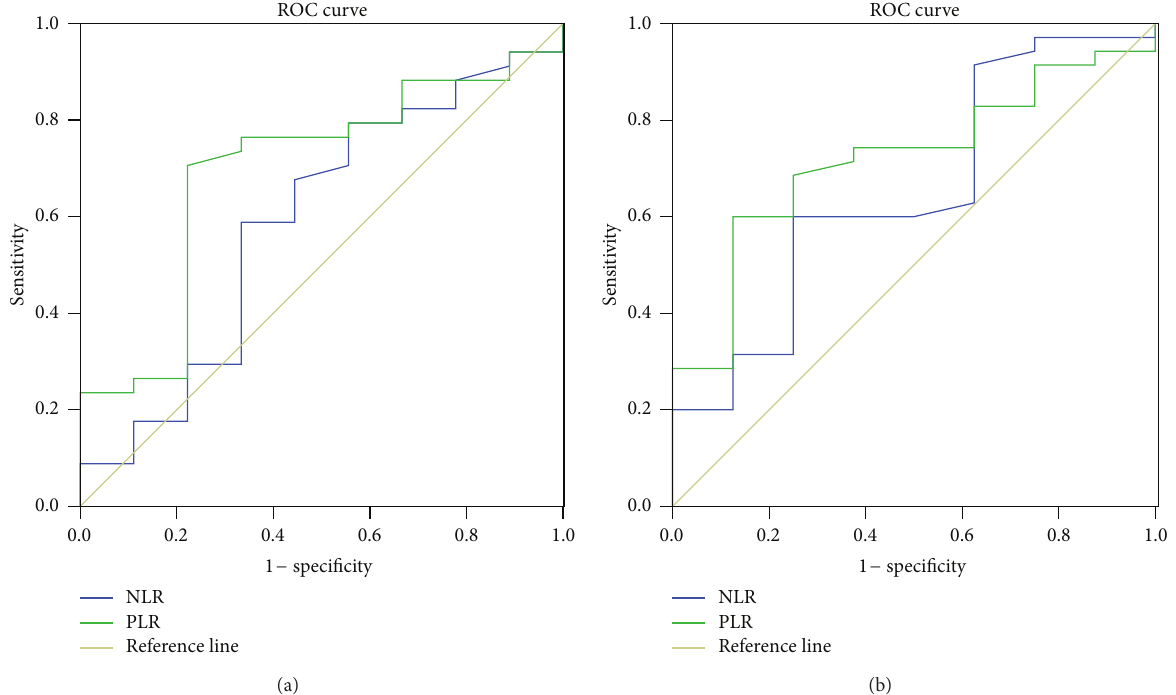
Figure 3: ROC curves for RFS (a) and OS (b) prediction. ROC curves were plotted to verify the accuracy of NLR and PLR for RFS and OS prediction. The AUC were 0.588 for NLR and 0.694 for PLR according to RFS prediction (a). The AUC were 0.650 for NLR and 0.720 for PLR according to OS prediction